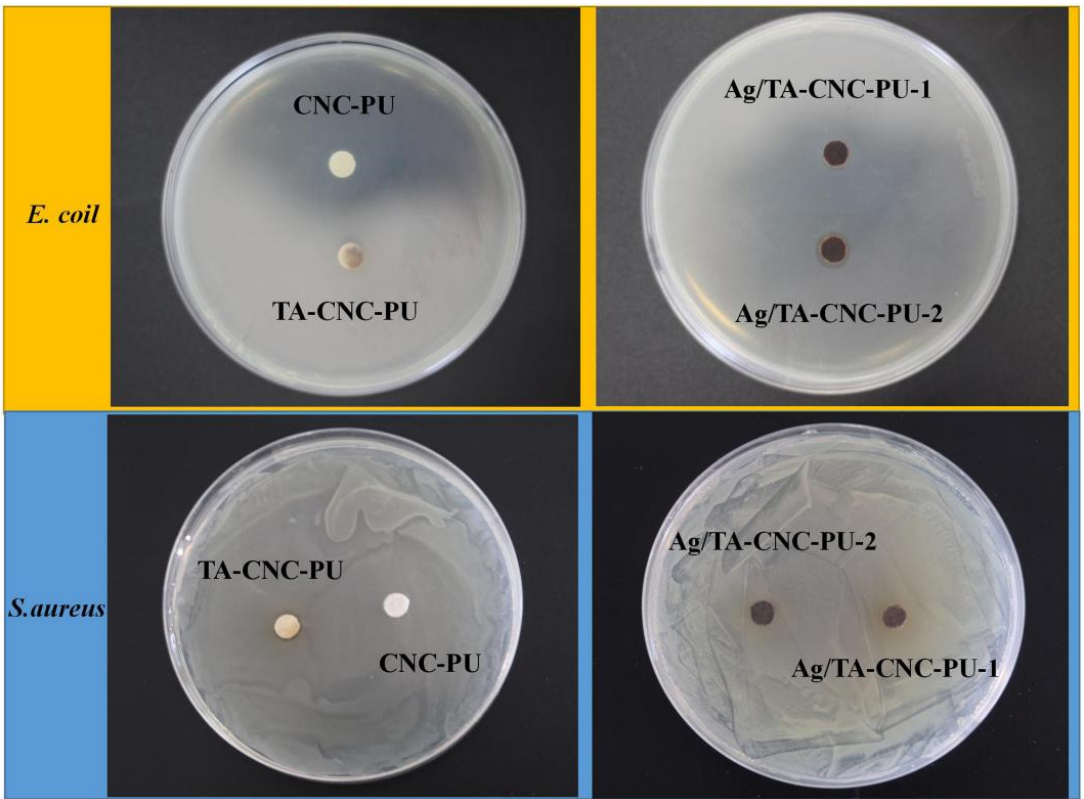
Figure 7. The antibacterial activity of CNCs-based PUs against E. coli and S.aureus .